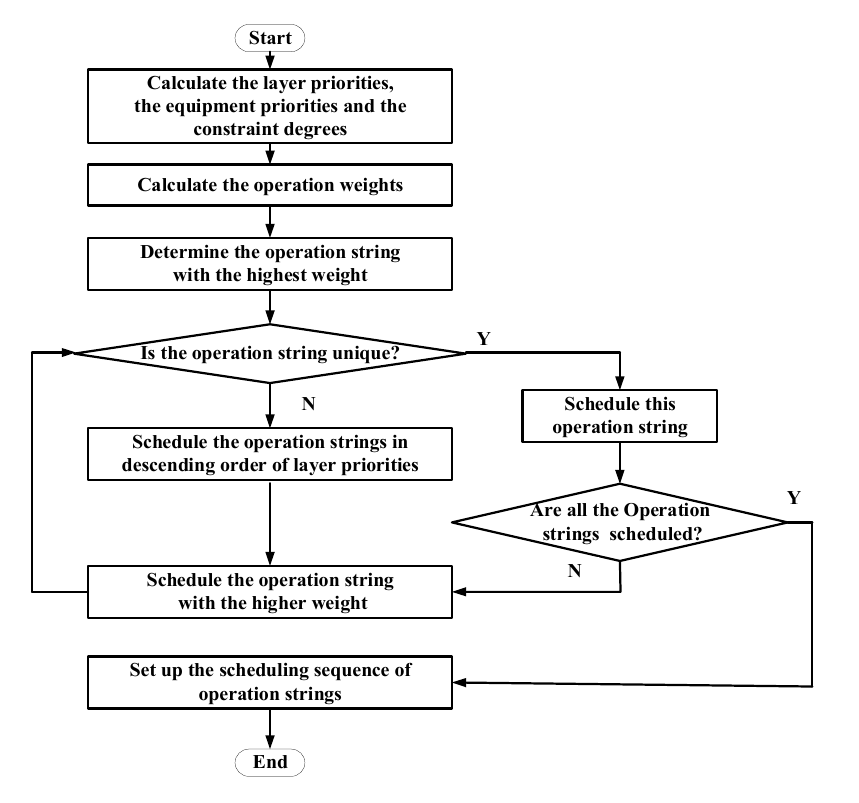
Figure 6. Flow Chart of the OWSS.